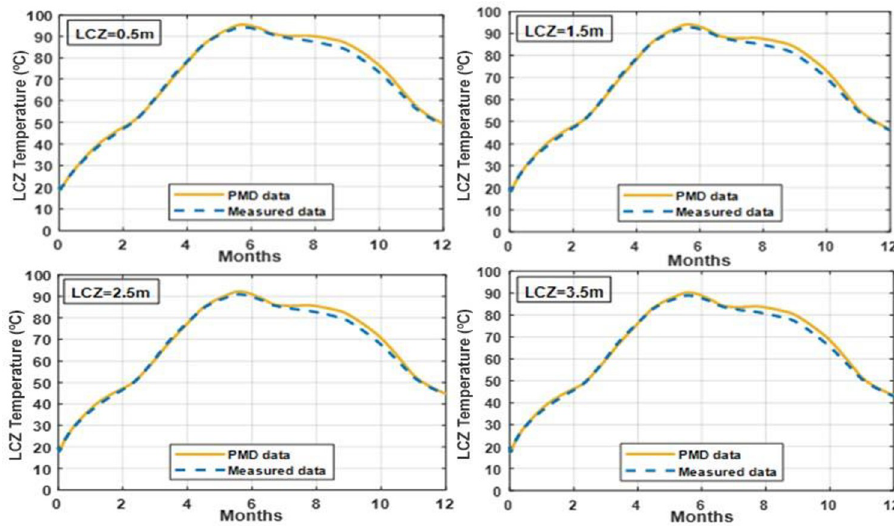
Fig 16. Effect of different thickness of LCZ on the temperature of LCZ with UCZ = 0.3m and NCZ = 1.0m under PMD and measured climatic conditions of Islamabad.